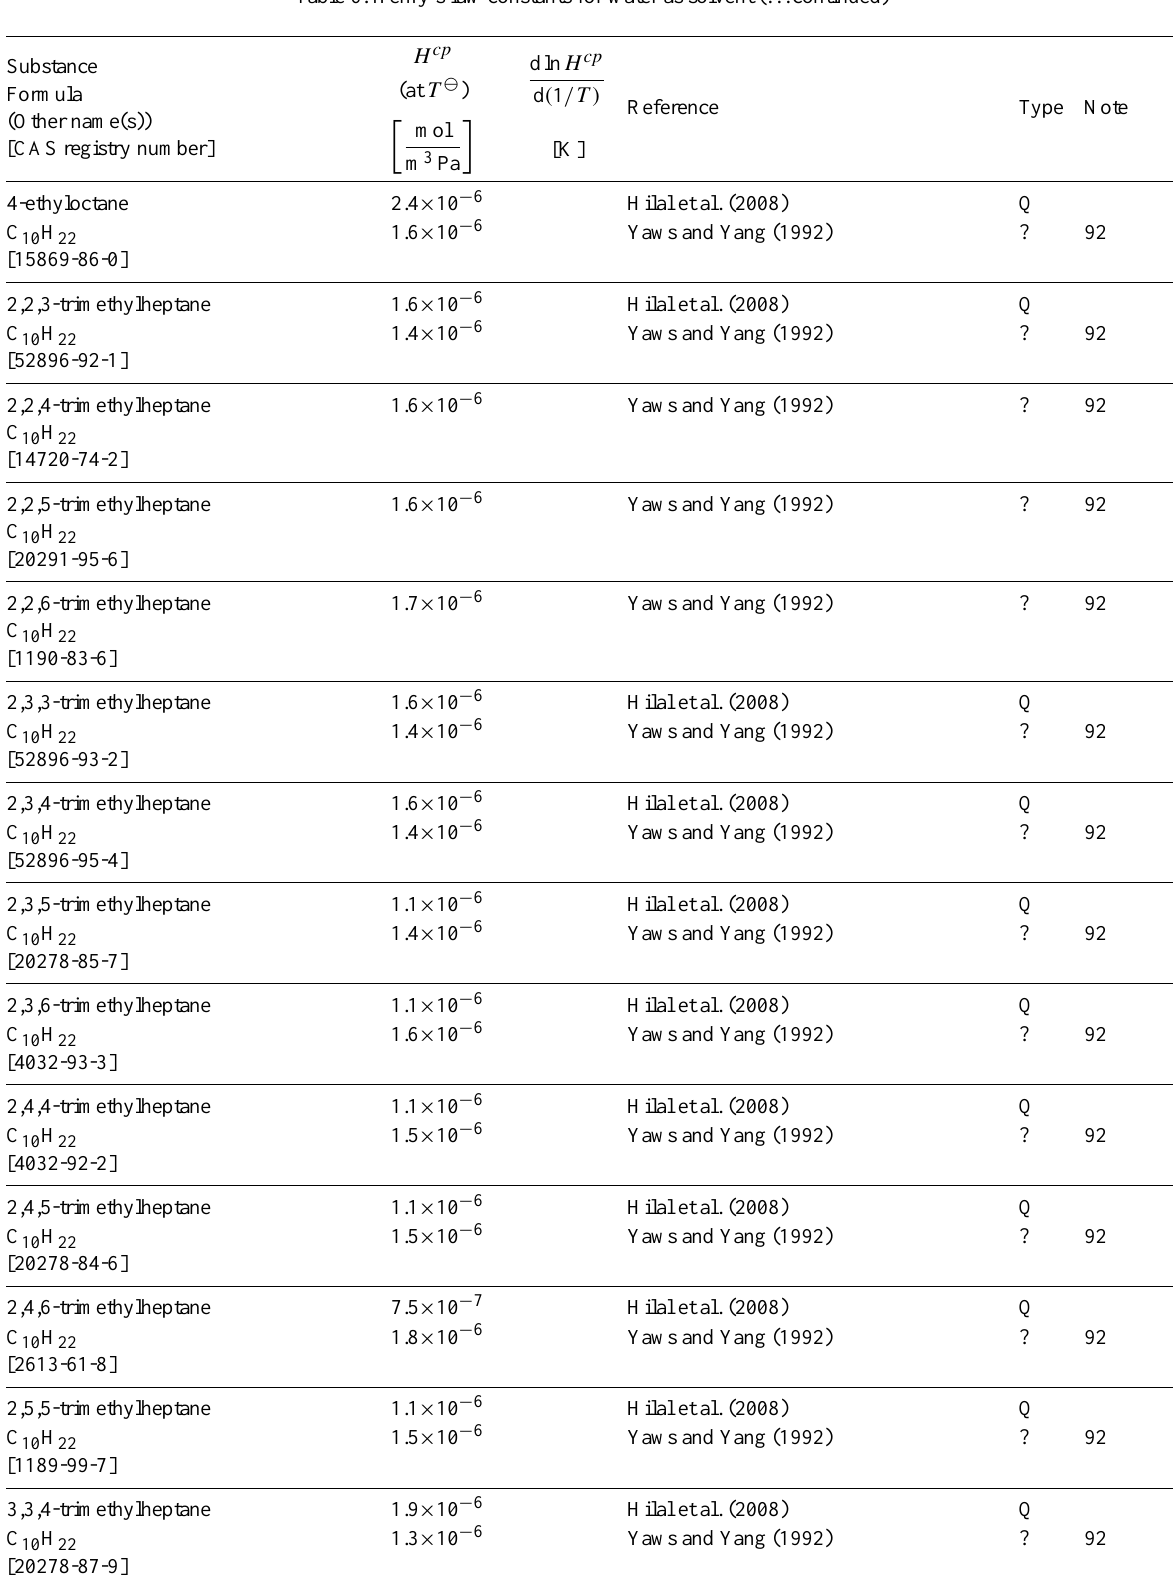
Table 6: Henry’s law constants for water as solvent